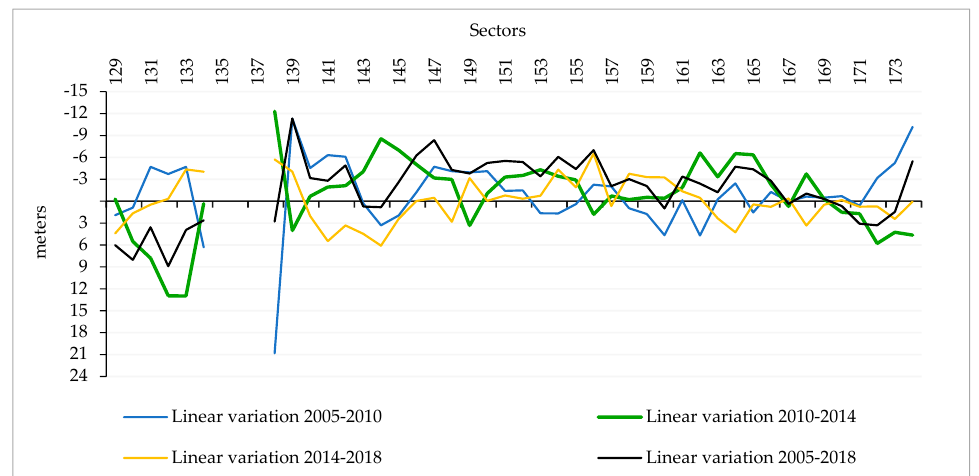
Figure 8. Shoreline displacement calculated per consequent timeframes, except for the black line, which represents the total displacement 2005–2018.